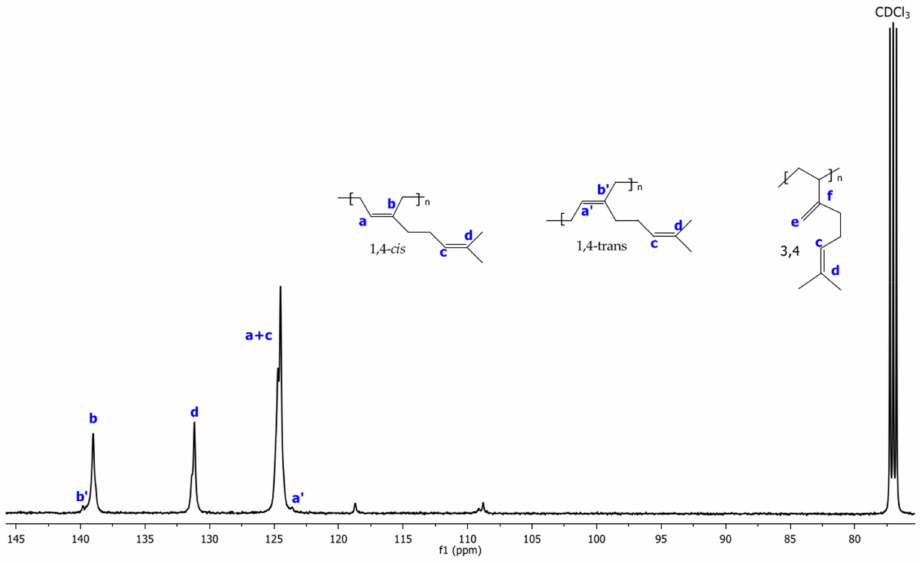
Figure 3. 13 C NMR spectra using CDCl3 as solvent of poly( β -myrcene) for Exp.